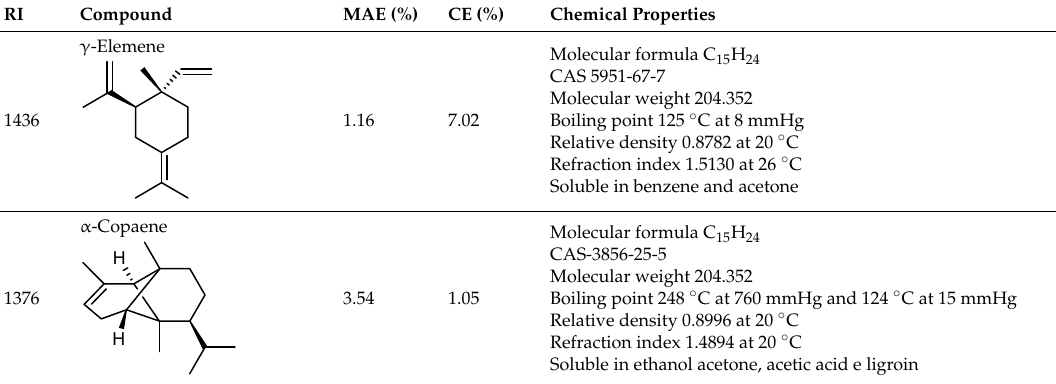
Table 5. Chemical composition and respective percentages of the main constituents in the volatile oil obtained by microwave-assisted extraction (MAE) and conventional extraction (CE) of P. emarginatus fruits.